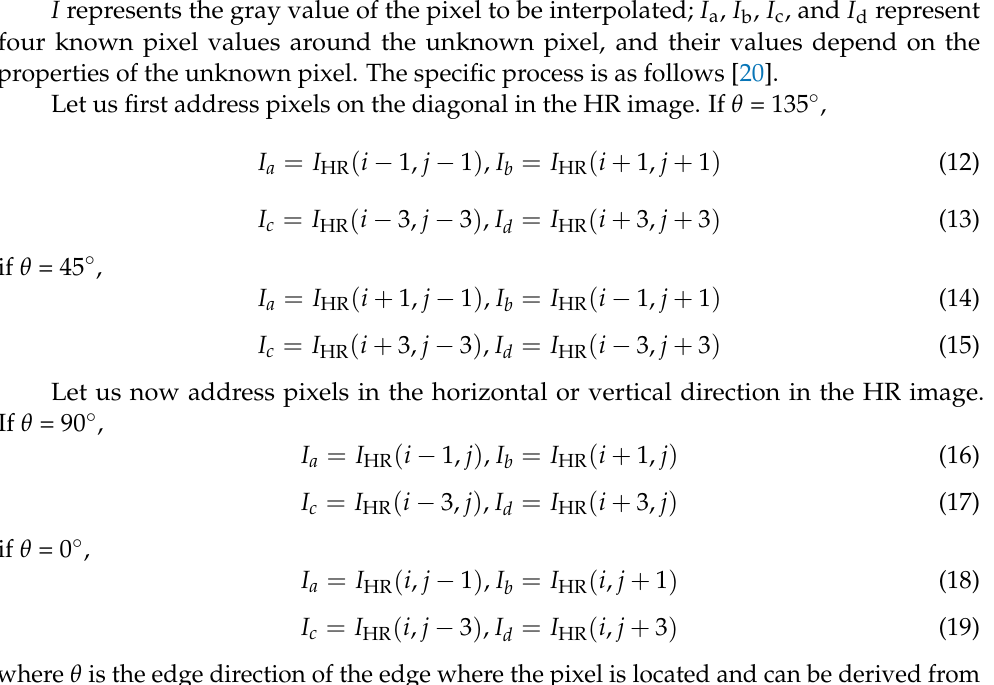
, I , I , and I represent a b c d